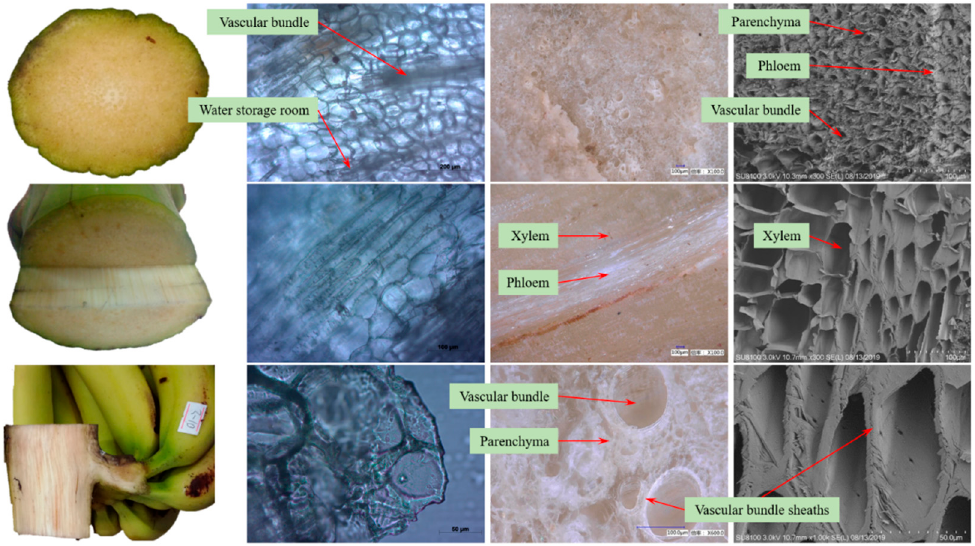
Figure 13. Macromorphology and microstructure of the bunch stalk. The minimum, maximum and average values of the diameter of the vascular bundle of bunch stalks we measured were 84, 138, and 111 µ m, respectively, with a standard deviation of 17 µ m and a coefficient of variation of 15.27%. The relationship between the diameter of the vascular bundle and the internode positions is shown in Figure 14. Moisture Content 1, Moisture Content 2, and Moisture Content 3, shown in the figure, represent the moisture contents of the bunch stalks, that is, 93%, 91%, and 84%. By analyzing the measurement results of the diameter of the vascular bundle of bunch stalks, we found that the variety and moisture content have no significant effect on the diameter of the vascular bundle. The distribution interval of the diameter of the vascular bundle is shown in Figure 15. According to the above measurement results, we conclude that the average value of the diameter of the vascular bundle is 0.11 mm, the distribution interval is 0.084~0.138 mm, and the corresponding peak value of the distribution interval is 0.096~0.127 mm.